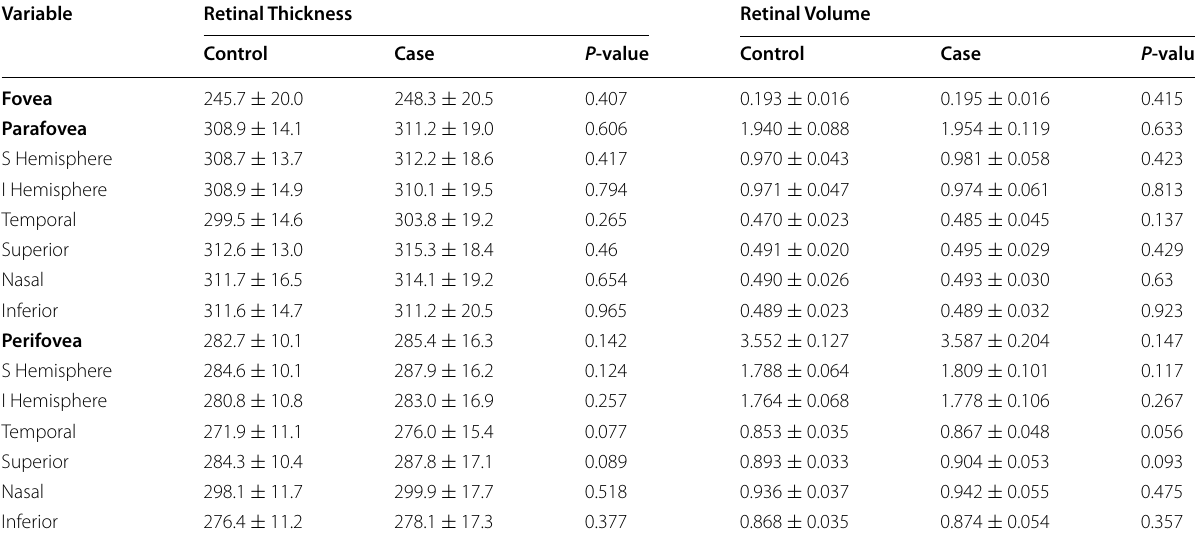
25) and Control Group ( N =